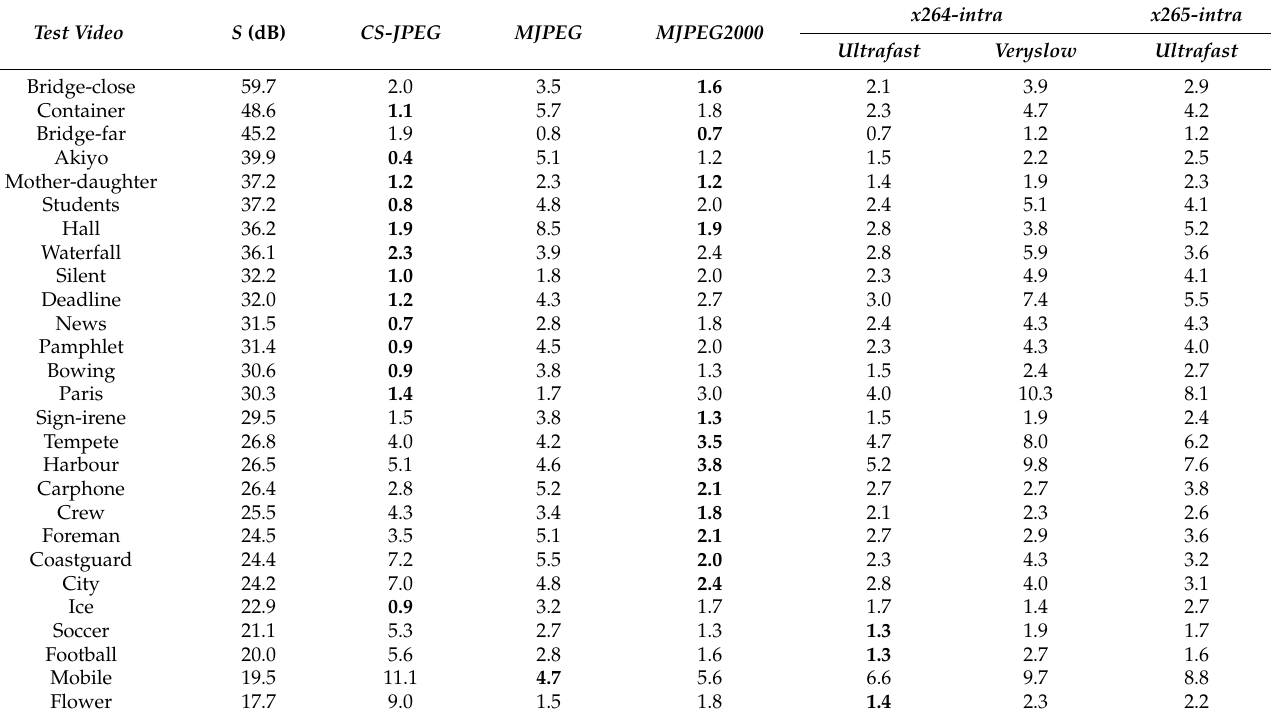
Table 8. Flickering level at R T = 600